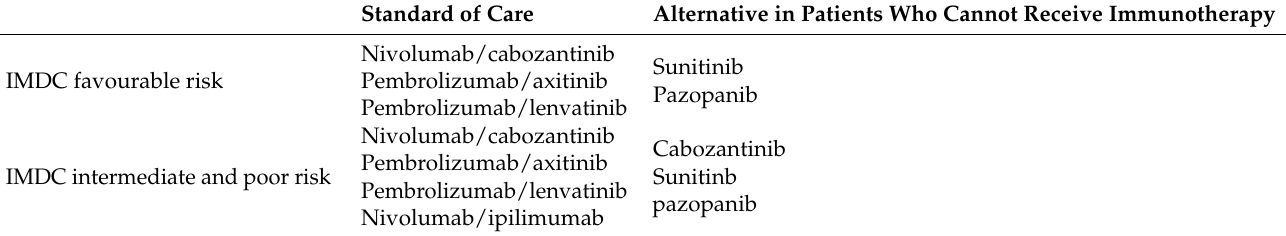
Table 3. First-line treatment options in metastatic CCRC.